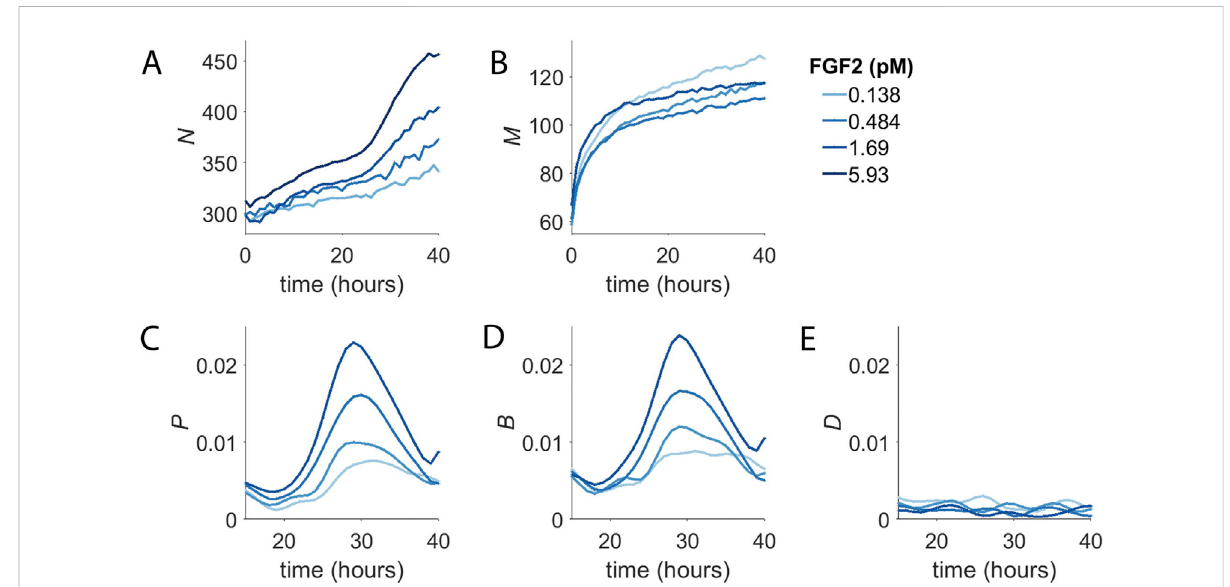
FIGURE 2 Concentration-Dependent Population Dynamics of Dermal Microvascular Endothelial Cells (DMECs) in the Presence of Pro-Angiogenic GrowthFactors. (A) .Thenumberofcells( N )overtimeforfourconcentrationsofFGF2. (B) .Thenumberofdeadcells( M )overtimefortheexperiment shown in panel (A) . (C) . The proliferation rate, p , for the same experiment as in panels A,B. (D) . The birth rate, B , as a function of time. (E) . The death rate, D , as a function of